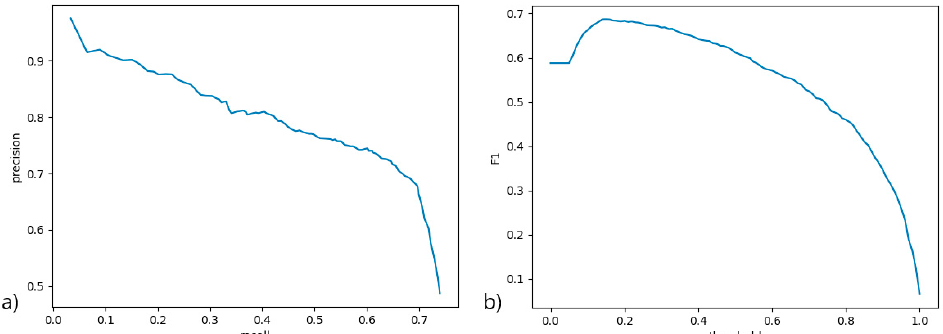
Figure 3. ( a ) The precision-recall (precision-sensitivity) curve signifying the ratio between the percentage of relevant detected samples to all samples and the percentage of correctly classified relevant samples, across various score thresholds; ( b ) the F1 score curve across various score thresholds to determine the most suitable threshold for filtering detected objects by score and demonstrating overall model